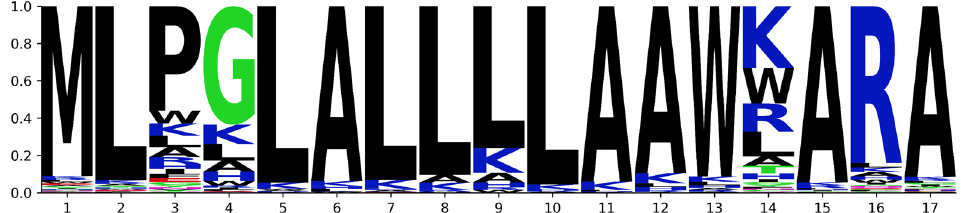
Figure 8. Sequence logo plot of 5948 mutant sequences with a predicted AiCPP value of 0.8 or higher. The X -axis denotes the position of the amino acid, and the Y -axis represents the frequency of the amino acid appearance rate.